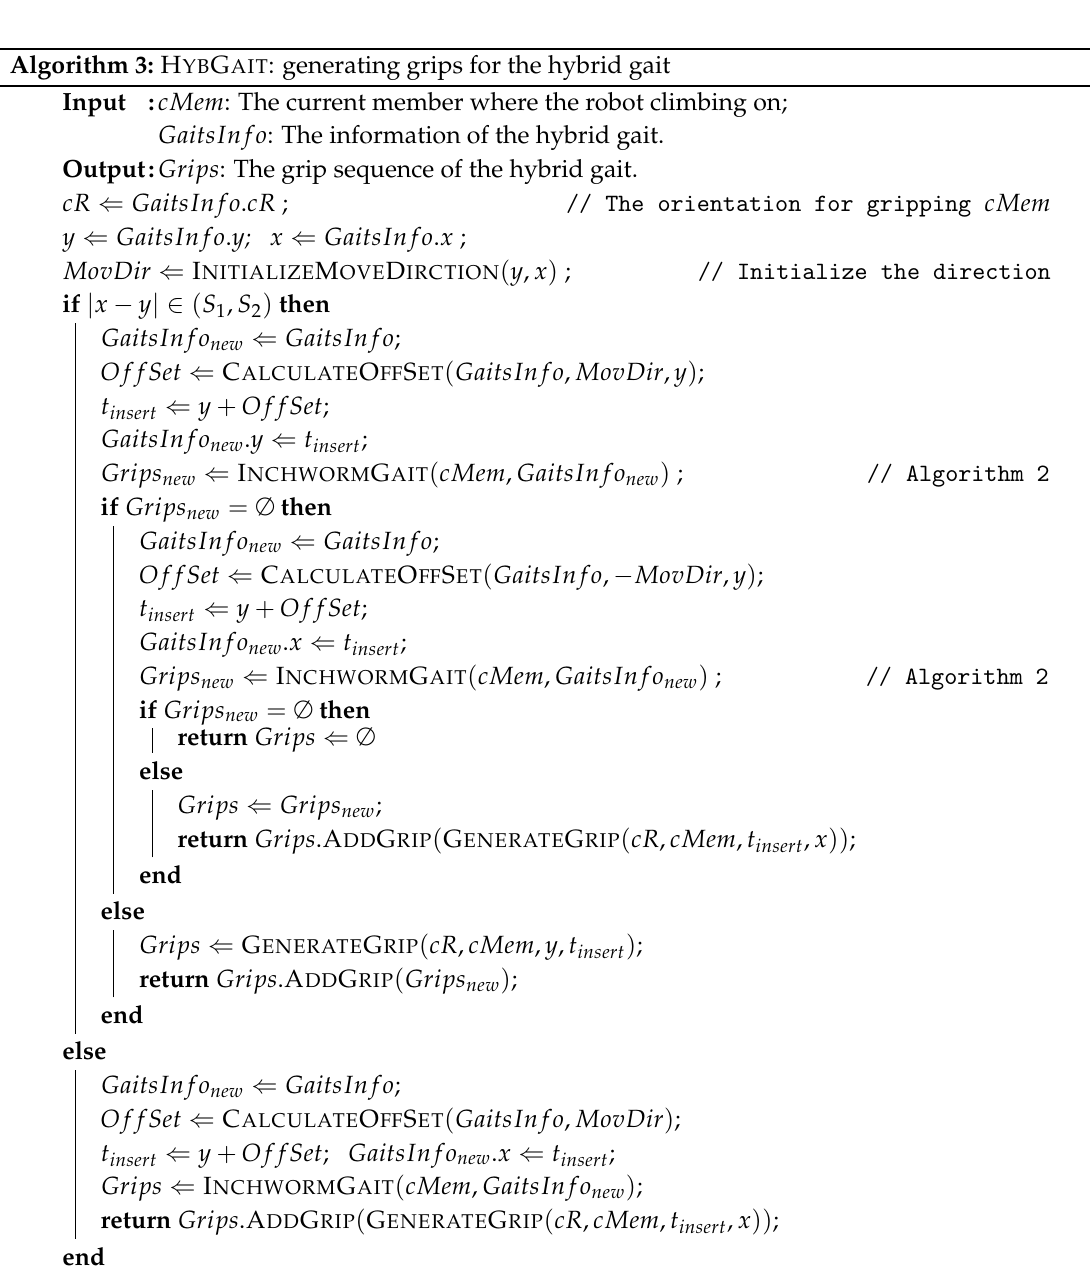
Algorithm 3: H YB G AIT : generating grips for the hybrid